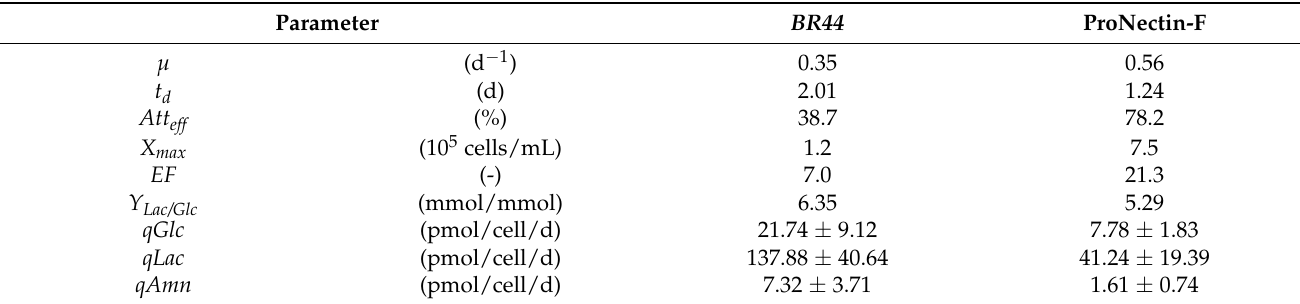
Table 4. Overview of main growth-dependent